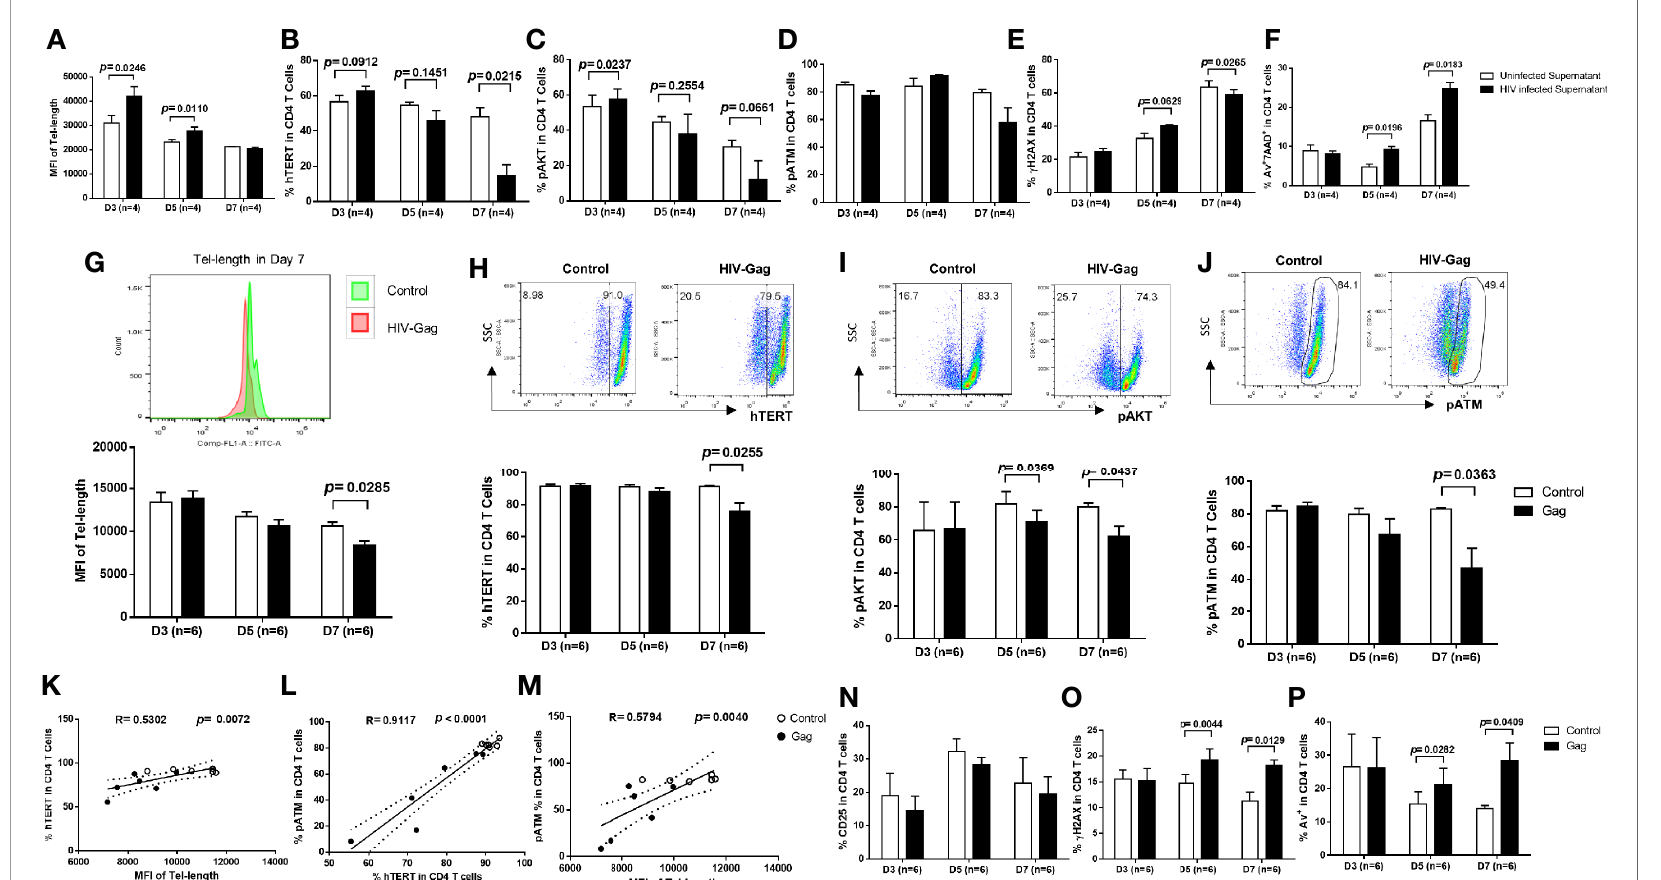
FIGURE 5 | HIV Gag protein shortens telomere length by diminishing telomerase, AKT, and ATM activities in primary CD4 T cells. (A – F) Primary CD4 T cells were incubated with supernatants derived from 7-day culture of HIV-infected or uninfected cells in the presence of HIV-entry blockers (Enfuvirtide and Maraviroc) for 3, 5, and 7 days, followed by measuring telomere length, telomerase, pAKT, pATM, g H2AX, and Av/ 7AAD by fl ow cytometry. (G) Representative overlaid histograms and summary data of the median fl uorescence intensity (MFI) of telomere length in Gag-treated and untreated CD4 T cells at days 3, 5, and 7, measured by Flow-FISH. (H – J) Representative dot plots and summary % of the hTERT, pAKT, and pATM expressions in Gag-treated and untreated CD4 T cells at days 3, 5, and 7. (K – M) Positive correlation between the MFI of telomere length and the % of hTERT, pATM, and hTERT, as well as pATM expression and telomere length in CD4 T cells with or without Gag treatment. (N – P) Summary data of the % of CD25 + , g H2AX + , and Av + cells in CD4 T cells treated with or without HIV